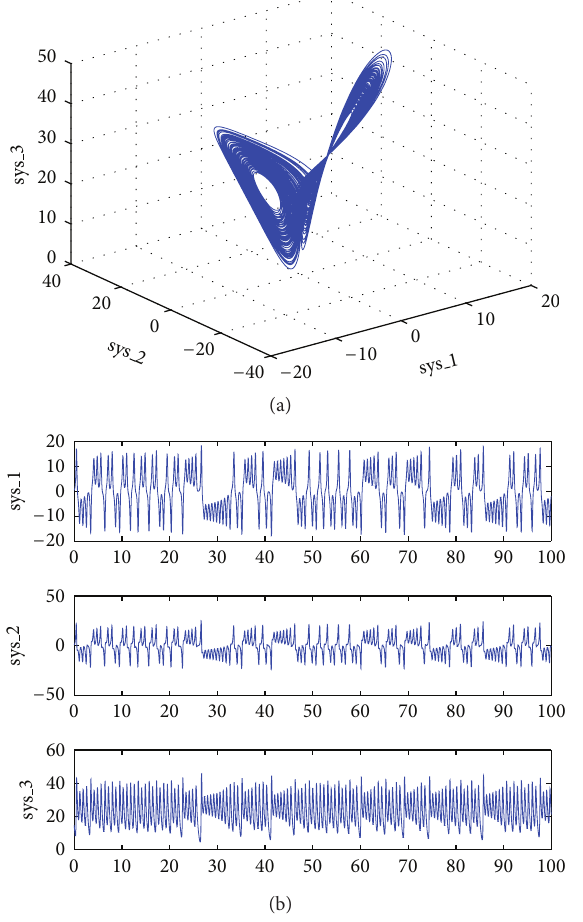
Figure 1: The attractor and the time series of the Lorentz system. Figure 2: The behavior similar with the R ̈ ossler system (initial value